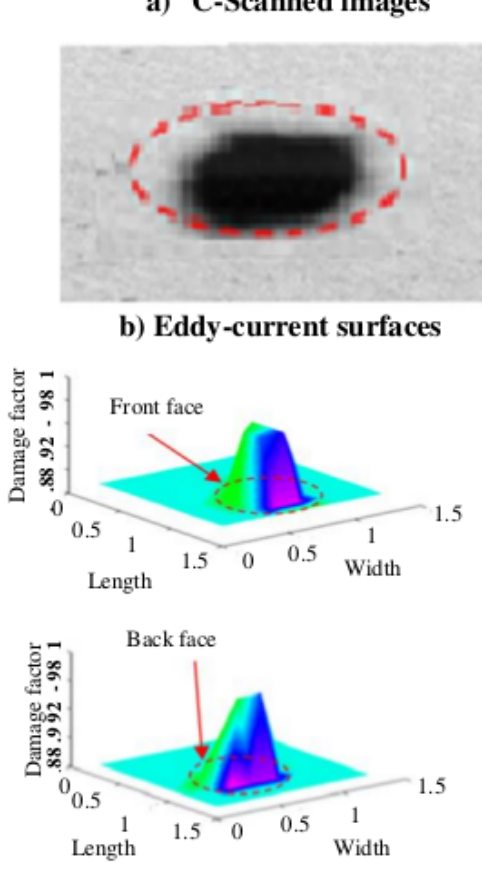
Figure 10: a) C-scan images and b) Eddy-current